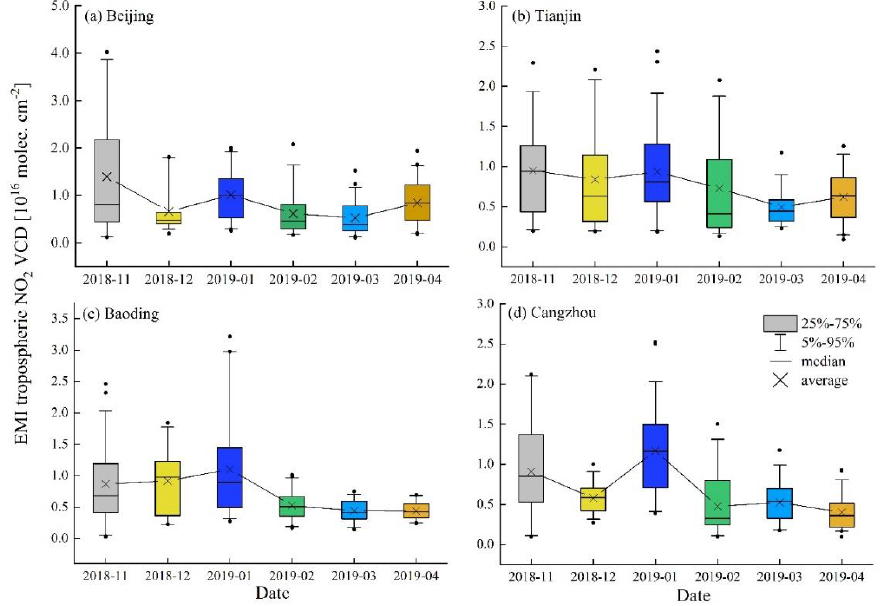
Figure 5. Statistical data representing the variability of the daily tropospheric NO 2 column values and the average value of the whole month, based on data collected from EMI observations for November 2018 to April 2019 on NO 2 in Beijing ( a ), Tianjin ( b ), Baoding ( c ), and Cangzhou ( d ).